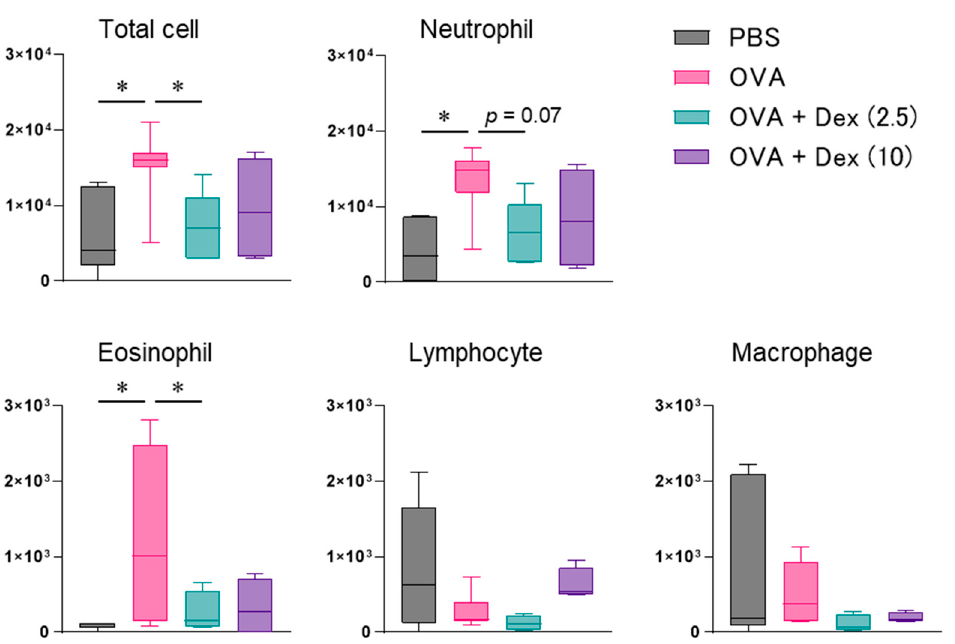
Figure 3. Effect of dexamethasone (Dex, 2.5 or 10 mg/kg) on allergen-evoked nasal cell infiltration in Th17 cell-infused mice. Inflammatory cell numbers in nasal lavage fluid (NALF) were measured 6 h following the final ovalbumin (OVA) injection. Data are displayed as the box plot of 4–7 mice. PBS, phosphate-buffered saline. * p < 0.05, compared with OVA-injected mice (pink bar). It was previously reported that Th17 cell-mediated allergic bronchial inflammation was not affected by steroid treatment [7]. Therefore, we investigated the effect of Dex treatment on Th17 cell-dependent nasal responses. Allergen-evoked INR and NHR in Th17 cell-infused mice were significantly mitigated by administrating 2.5 and/or 10 mg/kg Dex (Figure 2). Neutrophil migration was also suppressed by Dex, though the effect